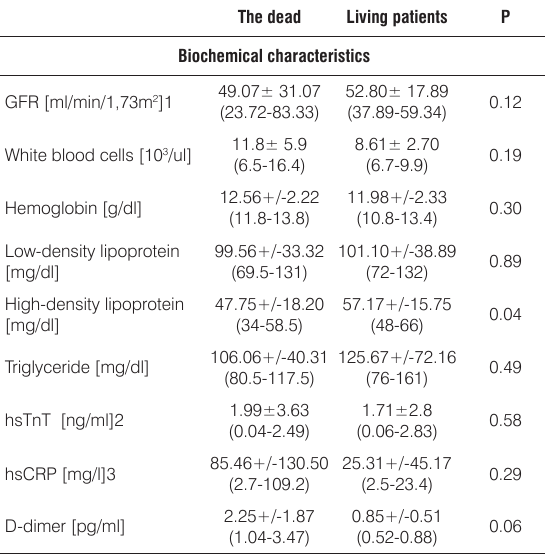
Table 2. Biochemical characteristics of the studied